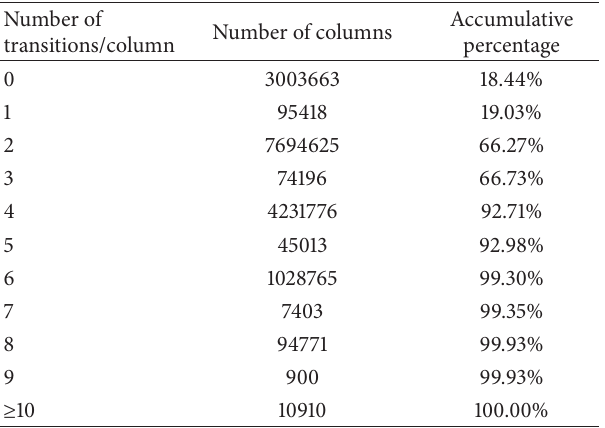
Table 1: Number of transitions/column for all line images in the